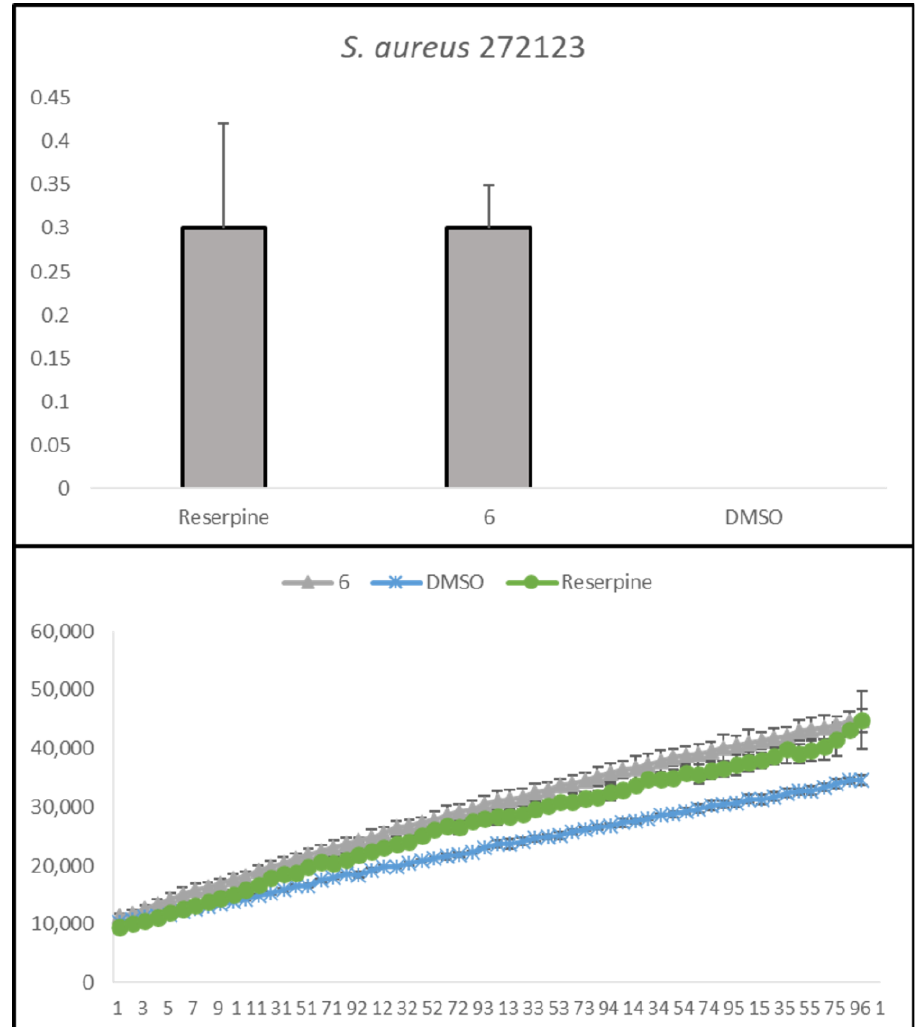
Figure 3. Accumulation of EB in the presence of trimethoxybenzoic acid derivative 6 on S. aureus 272123. DMSO: dimethyl sulfoxide (solvent); Reserpine: positive control. Statistical comparisons were performed using the t -test [vs. control (DMSO 1 % v/v )].